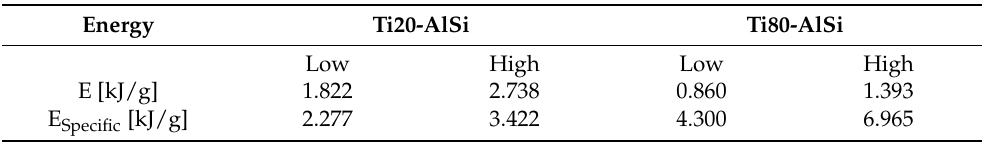
Table 3. Energy values as calculated from the experimental data and specific energy flowing through the AlSi10Mg phase. Energy Ti20-AlSi Ti80-AlSi Low High Low High E [kJ/g] 1.822 2.738 0.860 1.393 E Specific [kJ/g] 2.277 3.422 4.300